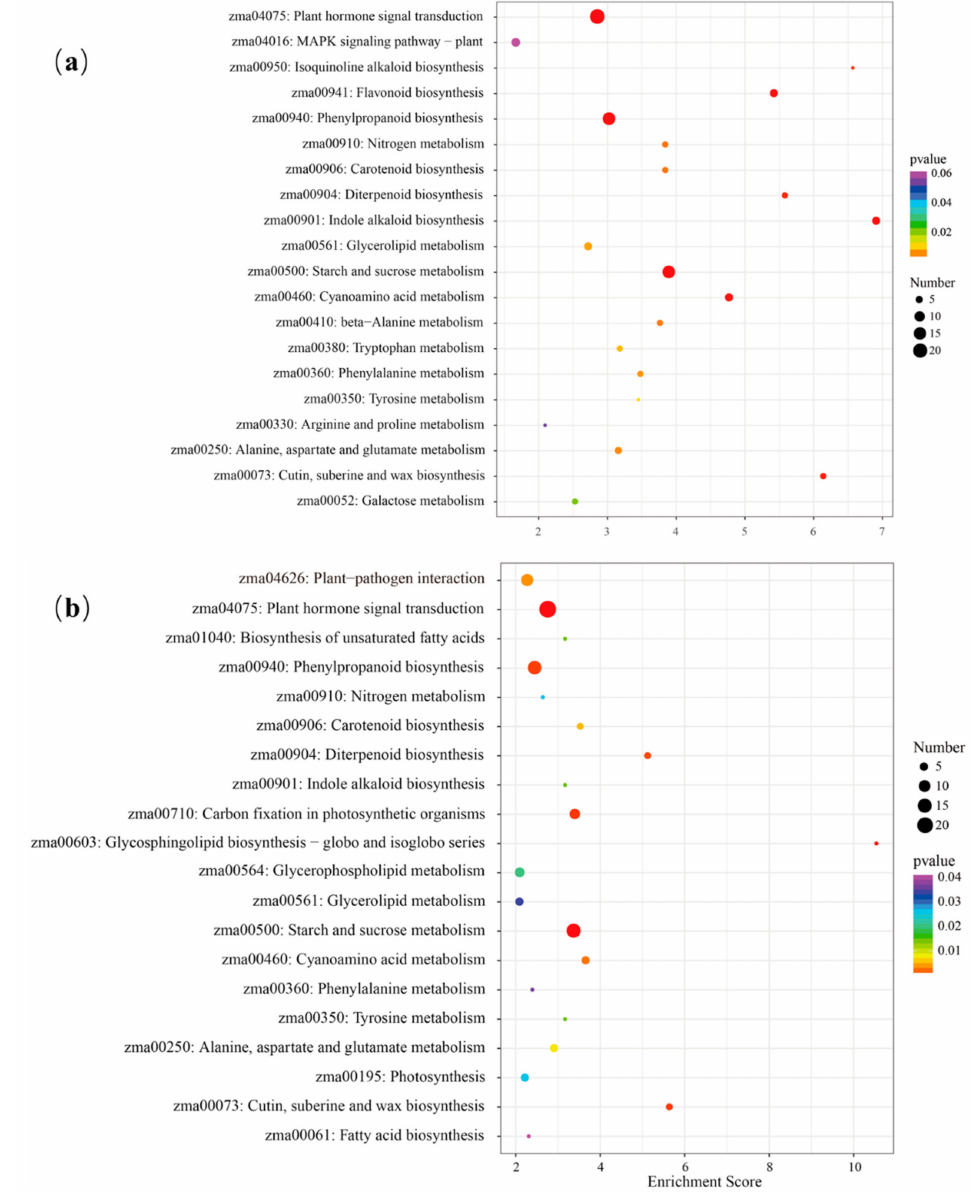
Figure 6. Top 20 enriched KEGG pathways in the ( a ) “MD vs. CK” and ( b ) “MD vs. LD” comparisons. Pathway entries with the corresponding number of genes (among those pathways with more than two genes) are shown, and the corresponding -log 10 p -value of each entry is sorted in descending order. The number of DEGs in each pathway is positively related to the size of plot, and the p -values shown in red are more